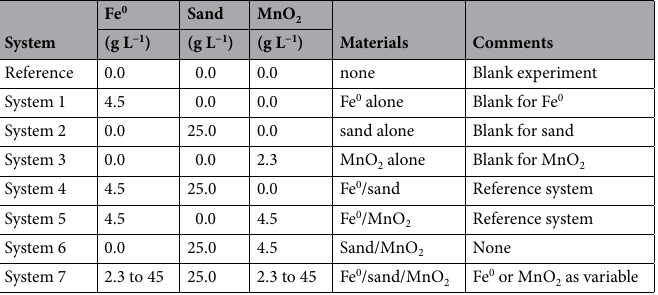
Table 1. Overview on the seven (7) investigated systems. The material loadings correspond to Fig.